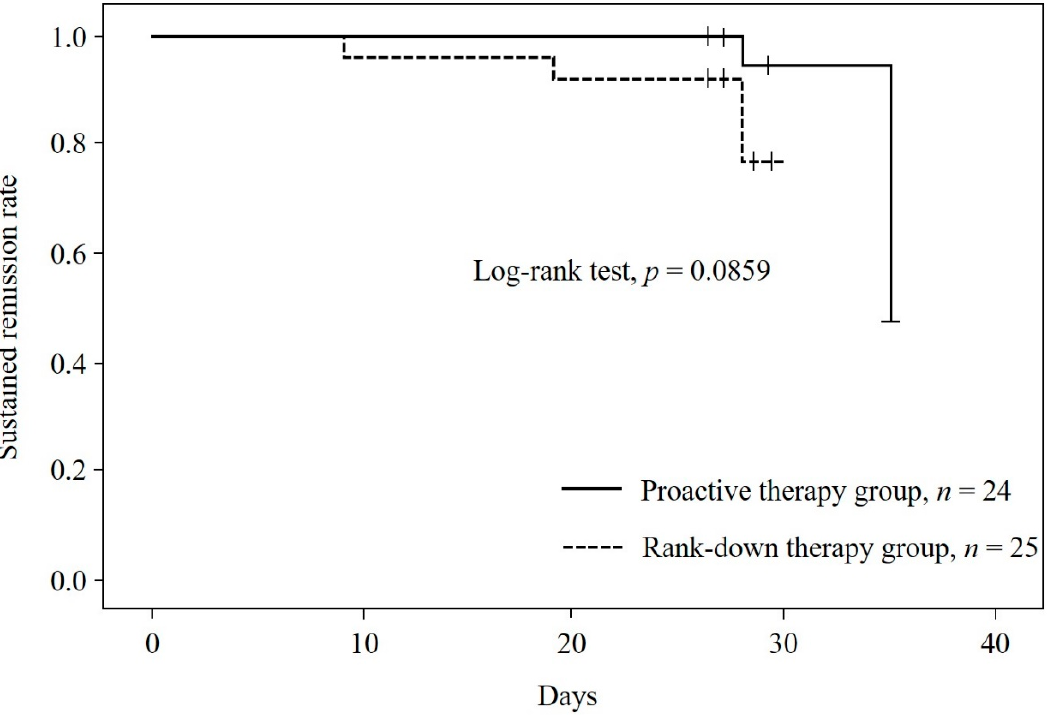
Figure 3. Kaplan–Meier estimate of sustained remission rate with proactive therapy versus rank- down therapy.